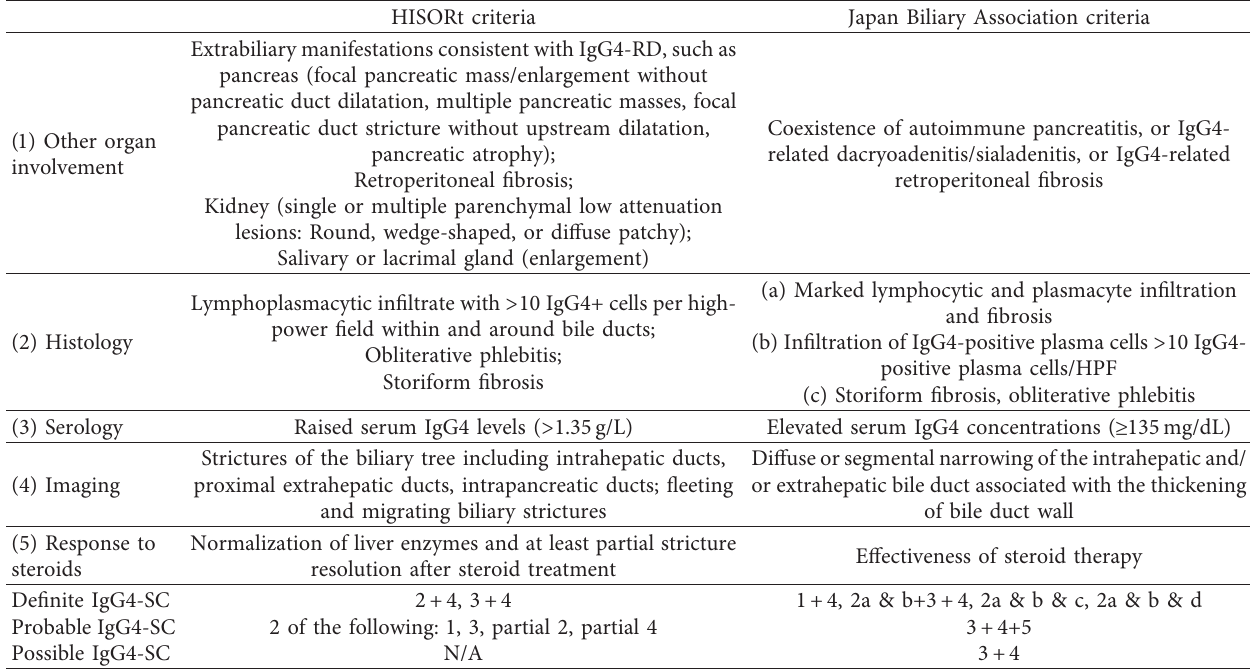
Table 1: Comparison between the HISORt criteria and the Japan Biliary Association criteria [4, 11]. HISORt